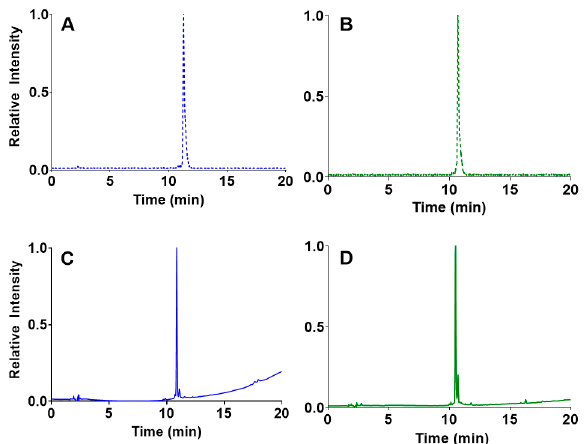
Figure 2. HPLC chromatograms of the radiofolates ( A ) [ 55 Co]Co-cm10 and ( B ) [ 55 Co]Co-rf42 (NaI detector). The non-radioactive precursors ( C ) cm10 and ( D ) rf42 are shown below their radiolabeled counterparts (UV detector, 254 nm).